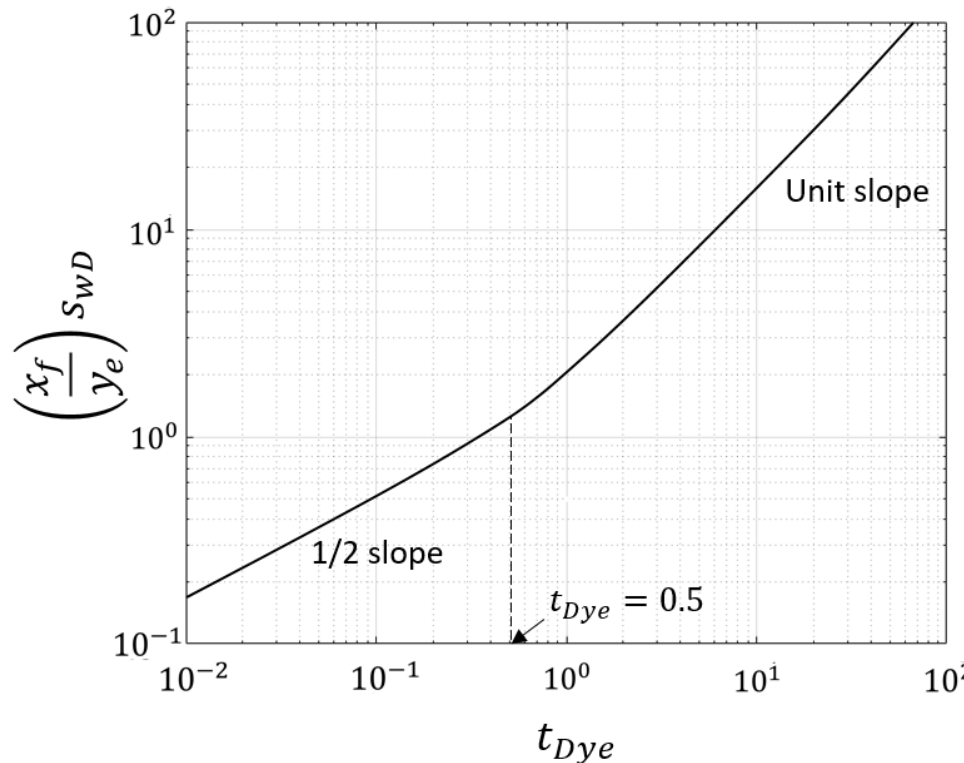
Figure 7. Representation of the drawdown solution for constant rate pumping test in a closed linear reservoir (redrawn from [69]).